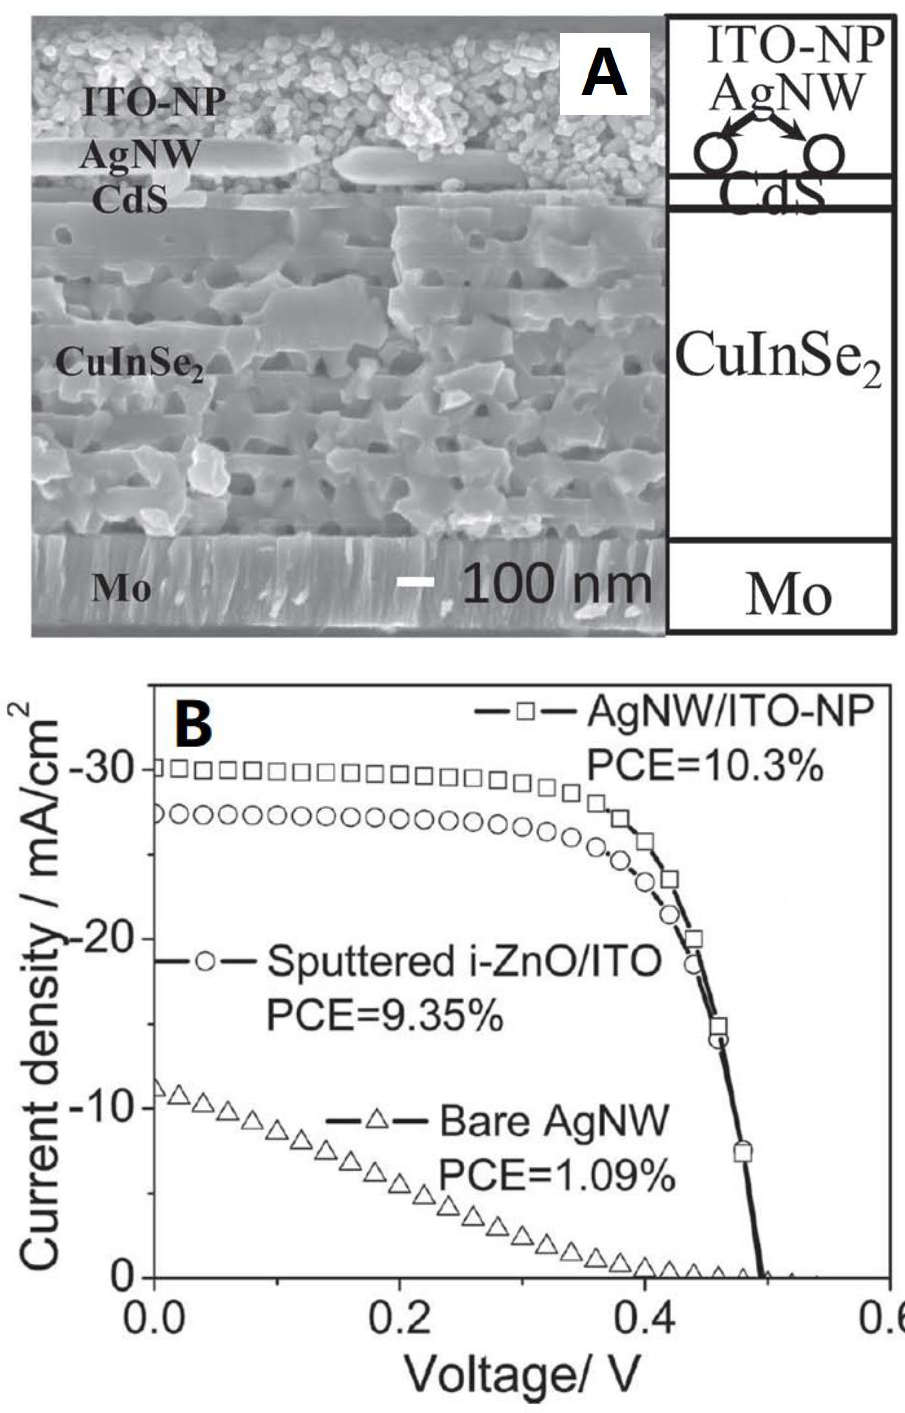
Figure 26. ( A ) Cross-sectional SEM image of the fully solution-processed CuInSe 2 TCE with an AgNW / ITO-NP top contact and ( B ) J-V curves of the CuInSe 2 TCEs using AgNW mesh, AgNW / ITO-NP film, and sputtered i-ZnO / ITO as top contacts [102].